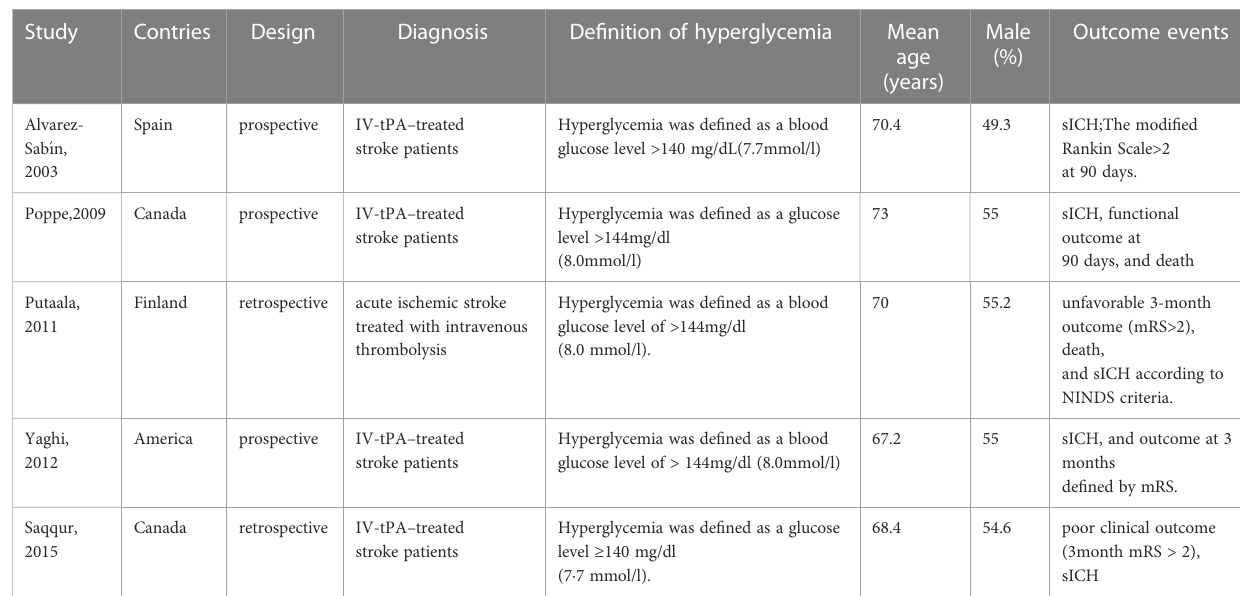
TABLE 1 Characteristics of the included cohort studies.